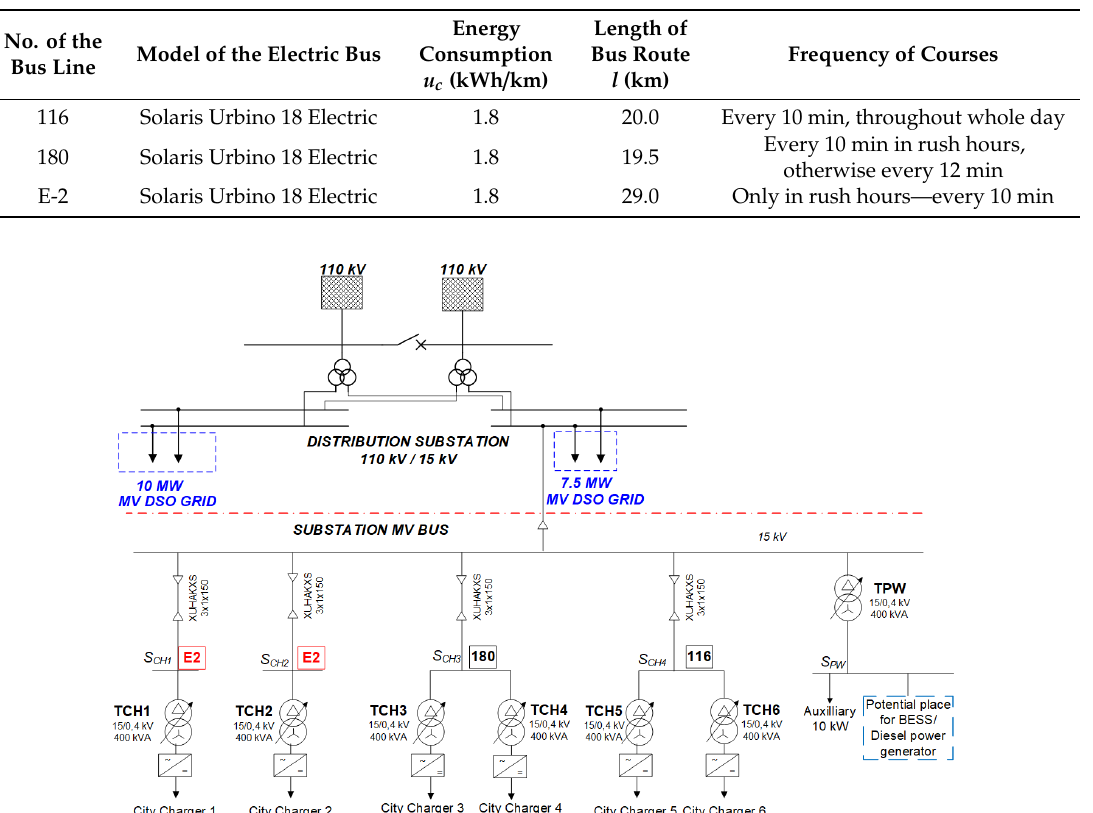
Table 4. Data of electrified bus lines stopping at the Wilan ó w terminus.